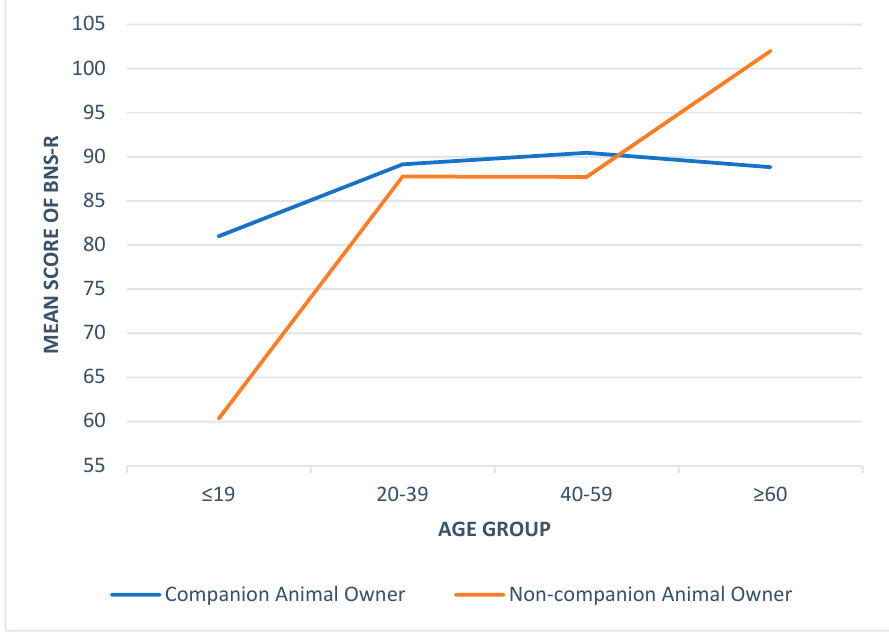
Figure 1. The comparison between owner and non-owner on BNS-R among age groups.